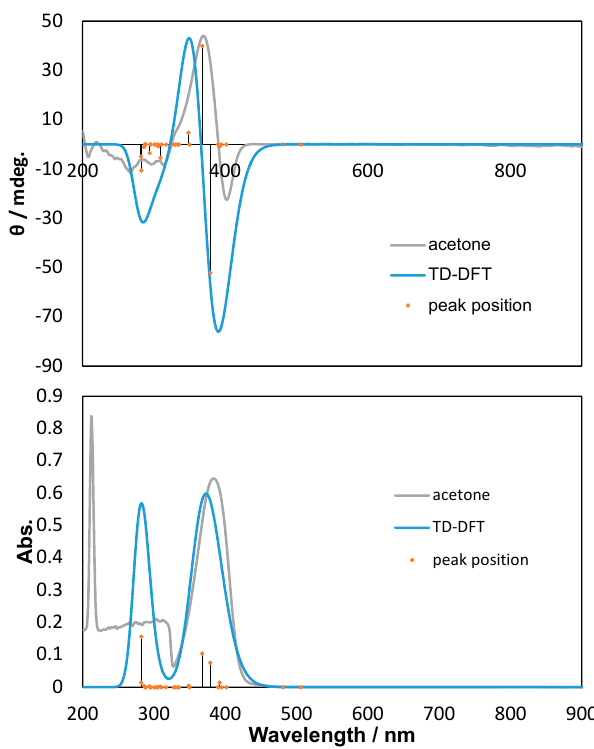
Figure 5. Experimental (in acetone solution) and simulated (UB3LYP/6-31G(d)) UV-Vis and CD spectra of Zn .